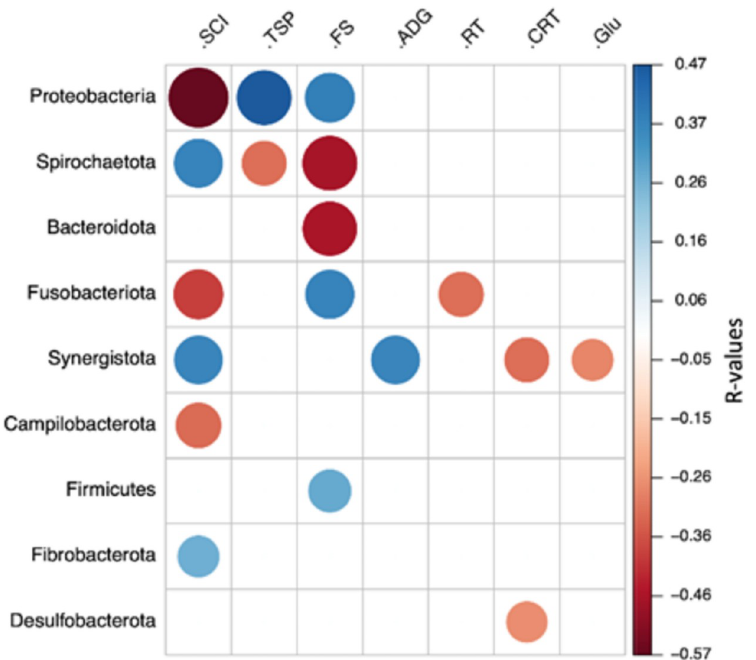
Fig 7. Heatmap showing the Spearman’s rank correlation coefficients and statistical significance between phyla abundance and calves’ parameters. Blue and red colors indicate significant positive and negative correlations, respectively ( P < 0.05). SCI, starter concentrate intake; TSP, total serum protein; FS, fecal score; ADG, average daily gain; RT, rectal temperature; CRT, creatinine; Glu, glucose.